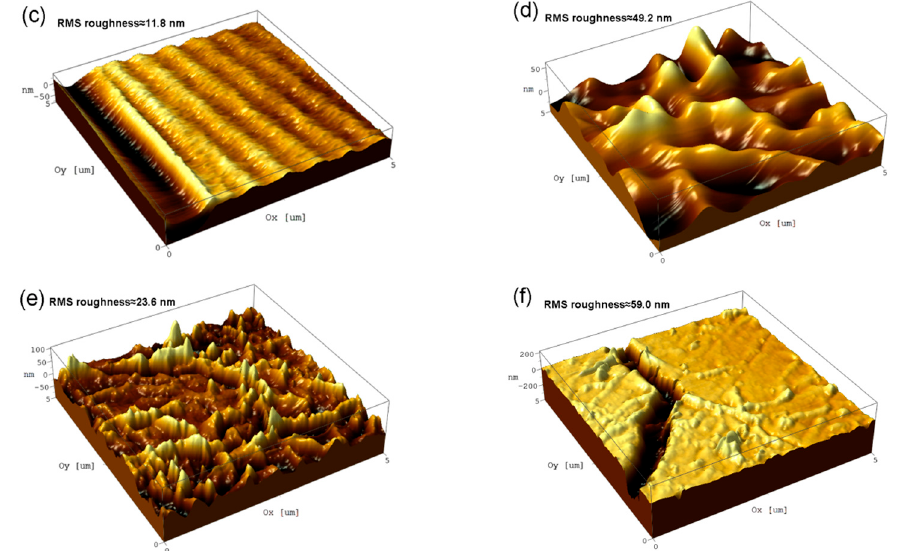
Figure 7. Shearing ( a ) and normal ( b ) adhesion strength of different samples. AFM images of different samples. ( c ) Pristine, ( d ) P, ( e ) C 2 -P, and ( f ) C 3 -P.